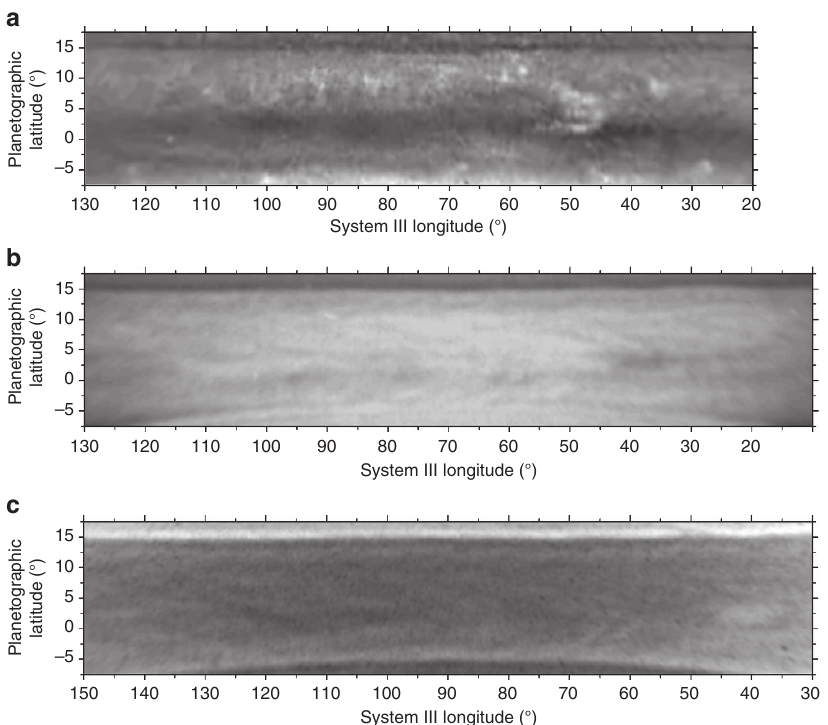
Figure 3 | Maps of Saturn’s Equator from Hubble Space Telescope. The images were obtained with the WFC3 on 29 June 2015 at the following wavelengths: ( a ) 750nm (red continuum); ( b ) 889nm (methane band); ( c ) 336nm (ultraviolet). Image details are given in Supplementary Table 2.